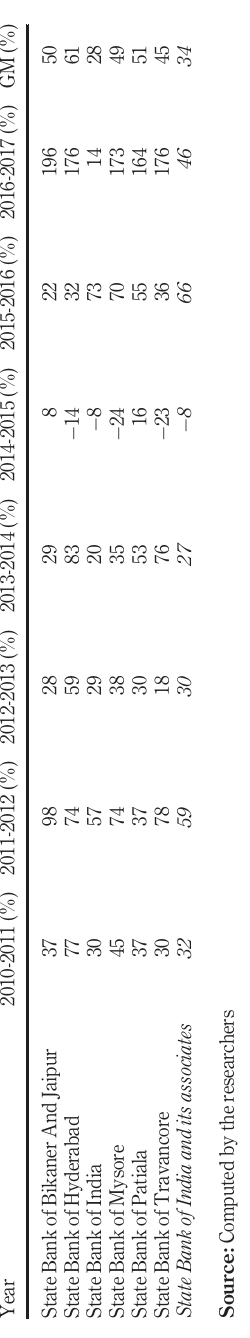
Table III. Year on year growth rate in gross NPAs in state bank of India and its